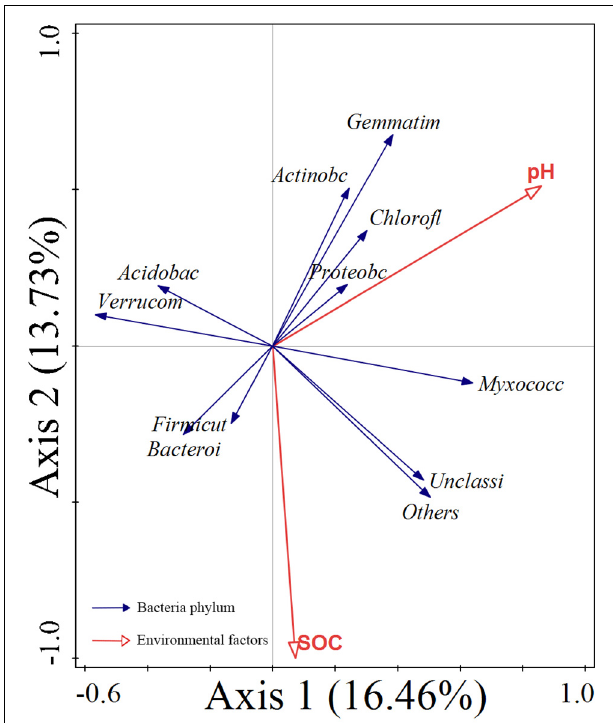
FIGURE 4 | RDA for the relationship between the bacterial phylum (blue arrows) and environmental factors (red arrows). SOC, soil organic carbon; Proteoba , Proteobacteria; Acidobac , Acidobacteriota; Verrucom , Verrucomicrobiota; Chlorofl , Chloroflexi; unclassi , unclassified Bacteria; Bacteroi , Bacteroidota; Gemmatim , Gemmatimonadota; Actinobc , Actinobacteriota; Myxococc , Myxococcota; Firmicut ,